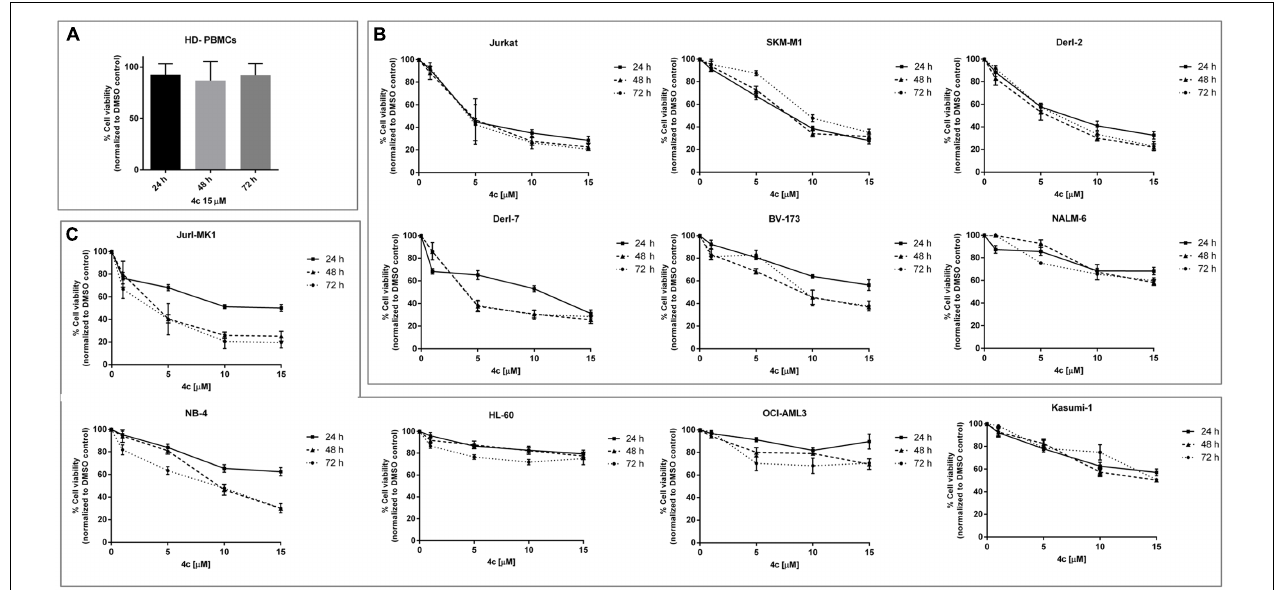
FIGURE 1 | Cell viability assay after 4c compound treatment in hematological malignancies. Viability of three healthy donors-peripheral blood mononuclear cells (HD-PBMCs) (A) , six lymphoid (B) , and five myeloid (C) cell lines was evaluated by MTS assay after treatment with 4c compound at different concentration (1, 5, 10, and 15 µ M) for 24, 48, and 72 h. Results are expressed as percent of cell viability normalized to DMSO-treated control cells. The bar-graphs represent mean with SD from three independent experiments.